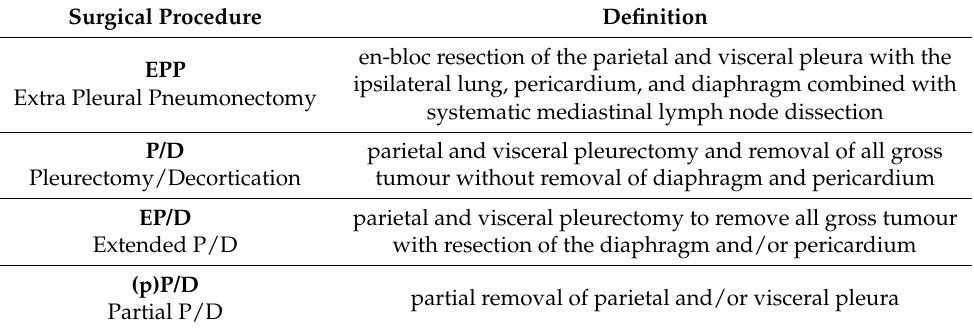
Table 2. Definition of surgical procedures according to IASLC [42] and